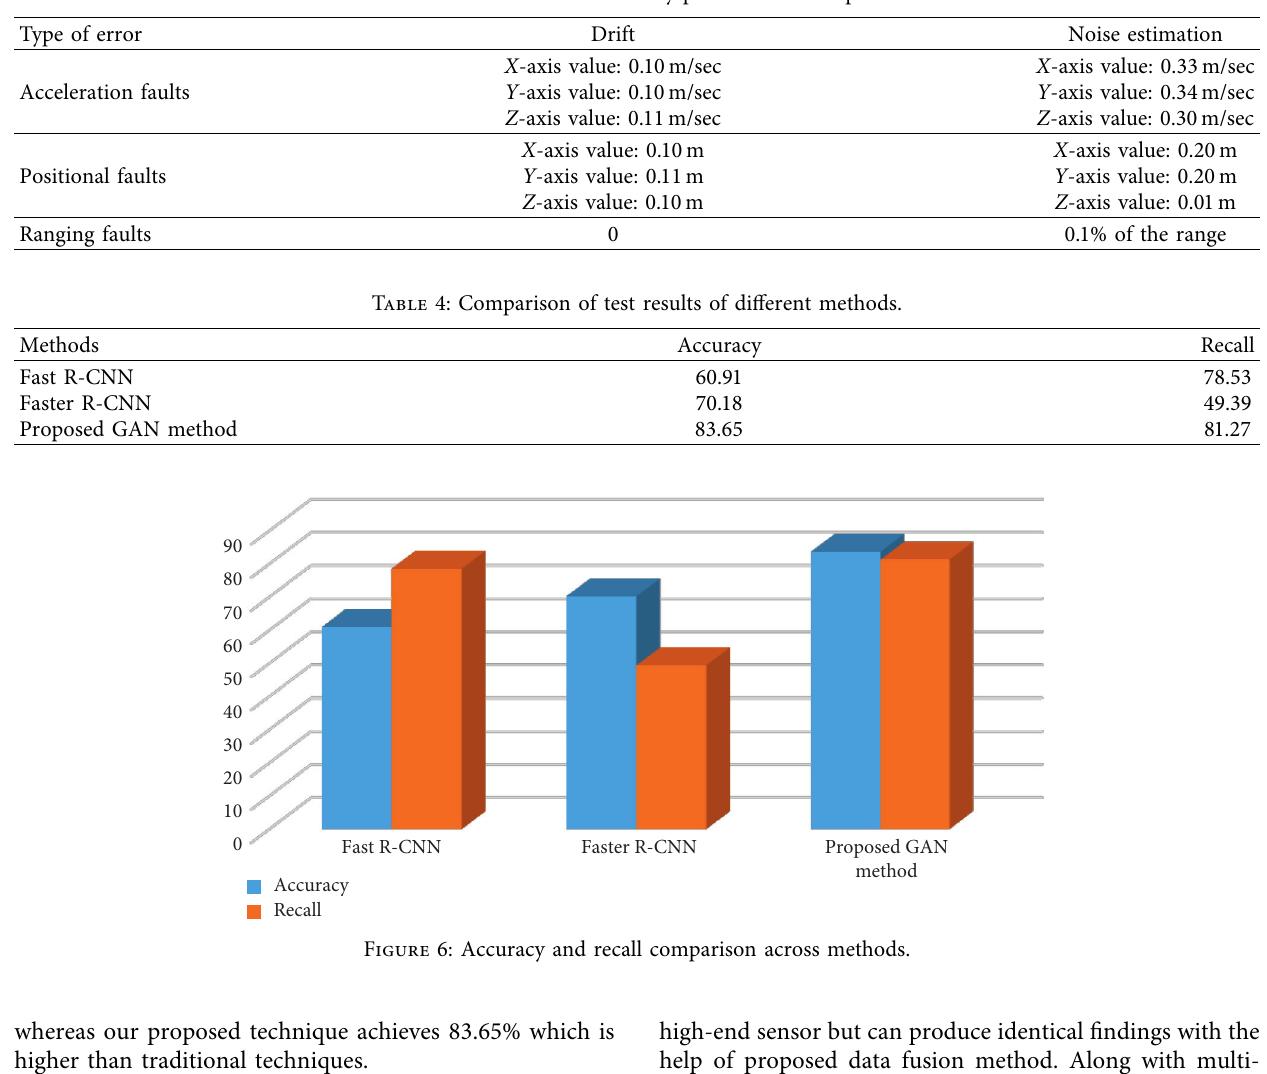
Table 3: Different sensor accuracy performance